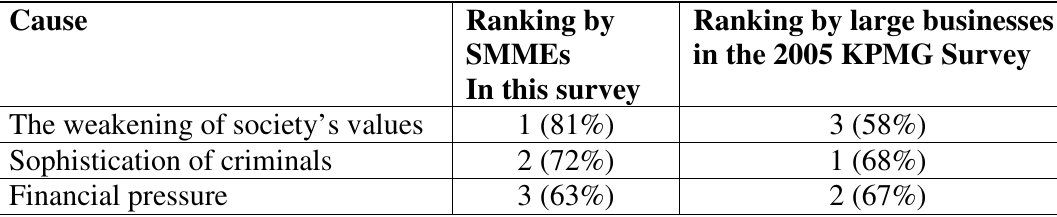
Table 2: Causes of fraud in South